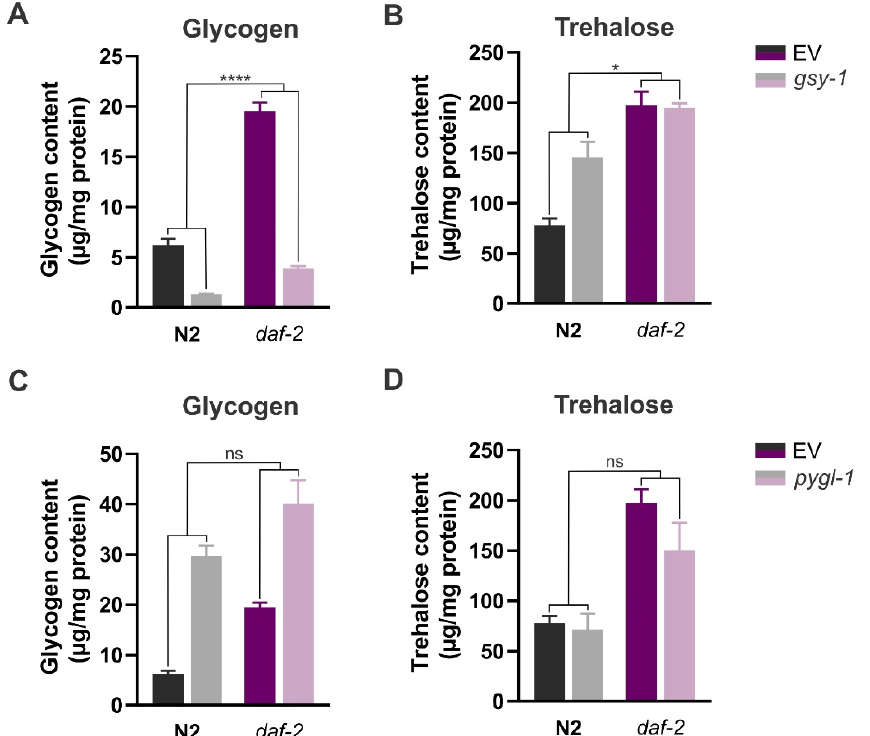
Figure 2. Suppressing glycogen synthesis and breakdown influences carbohydrate levels: glycogen and trehalose content in wild-type and daf-2(e1370) mutant treated with gsy-1 ( A , B ) and pygl-1 ( C , D ) RNAi, respectively. Error bars indicate SEM of three independent replicates. EV—empty vector control. ns: p > 0.05, * p ≤ 0.05, **** p ≤ 0.0001 (interaction, two-way ANOVA). The data are summarized in Table S2.